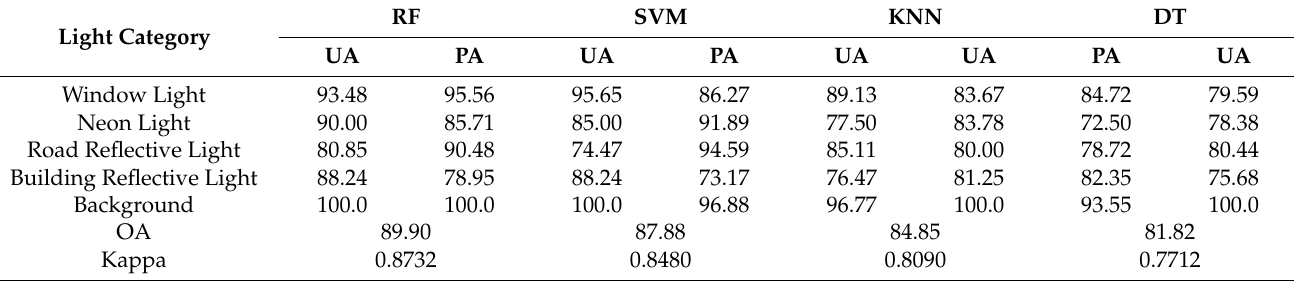
Table 6. Middle view region classification accuracy table (%).